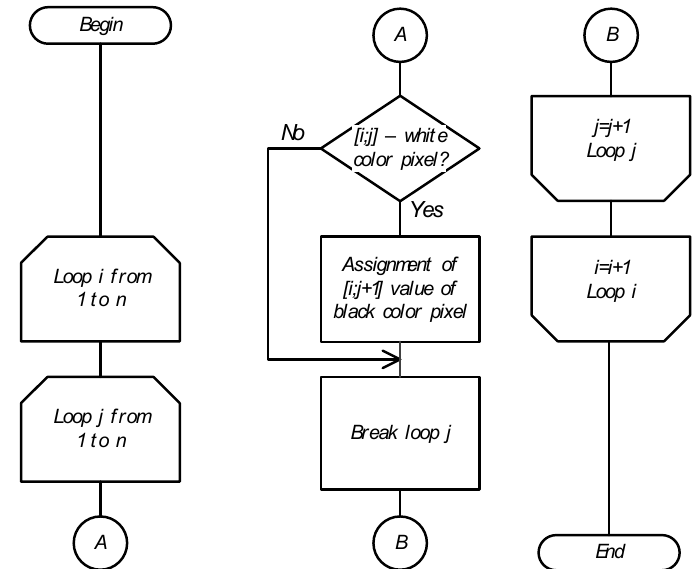
Figure 6. Modified flowchart for processing the source DICOM